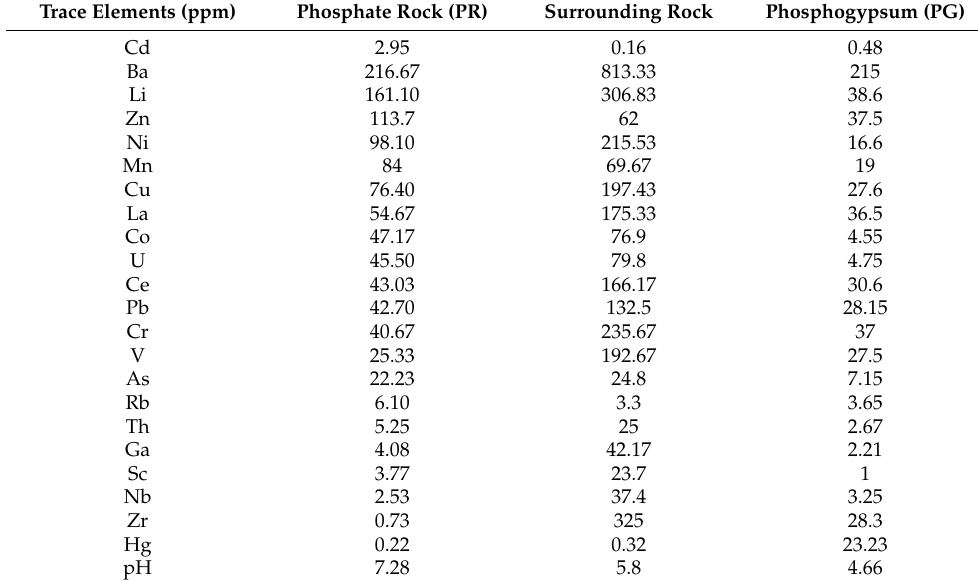
Table 2. Compilation of pH and trace element analysis in phosphate rock (PR) and phosphogyp- sum (PG). Trace Elements (ppm) Phosphate Rock (PR) Surrounding Rock Phosphogypsum